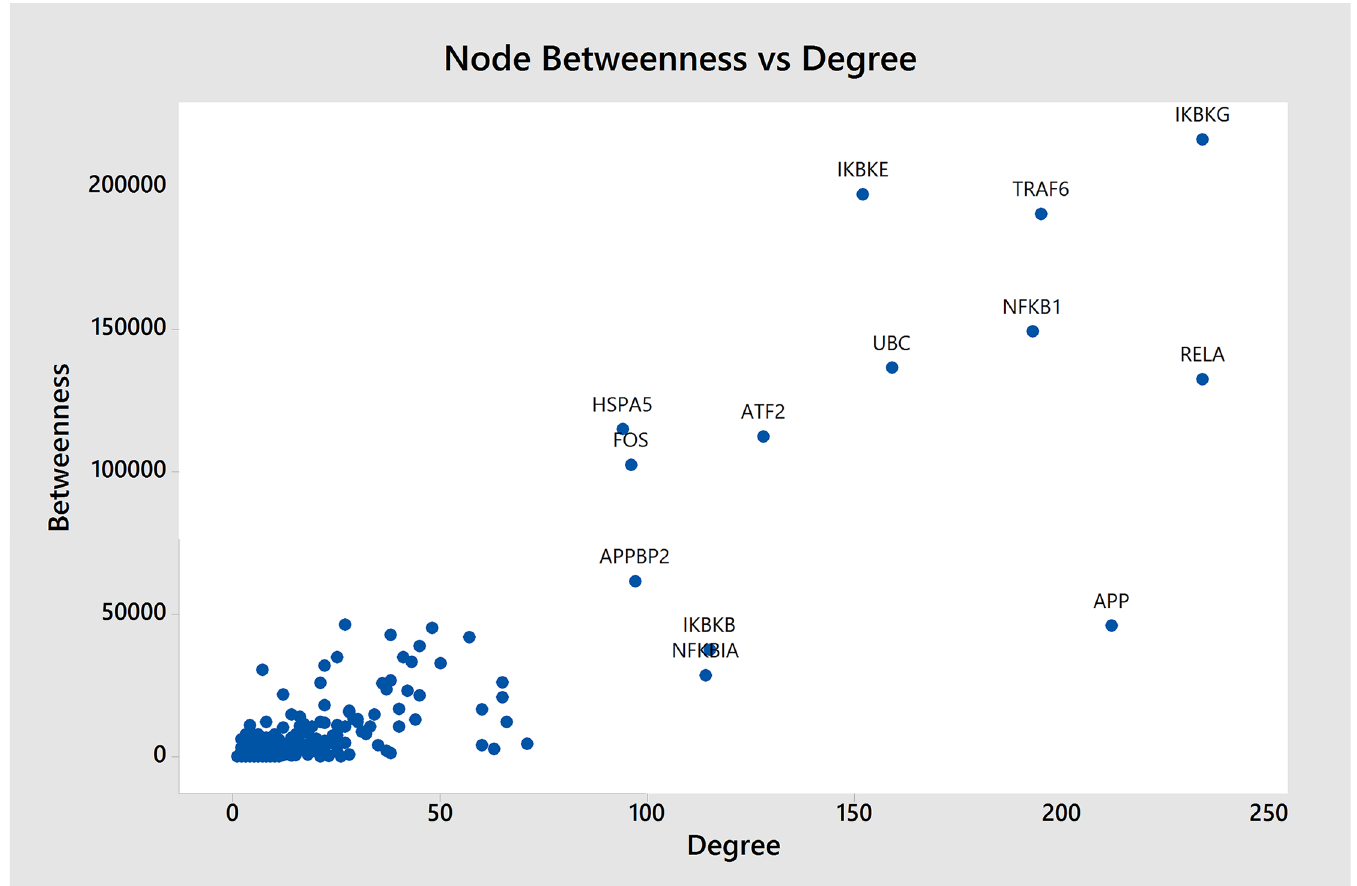
Fig 3. Scatterplot of the centralities